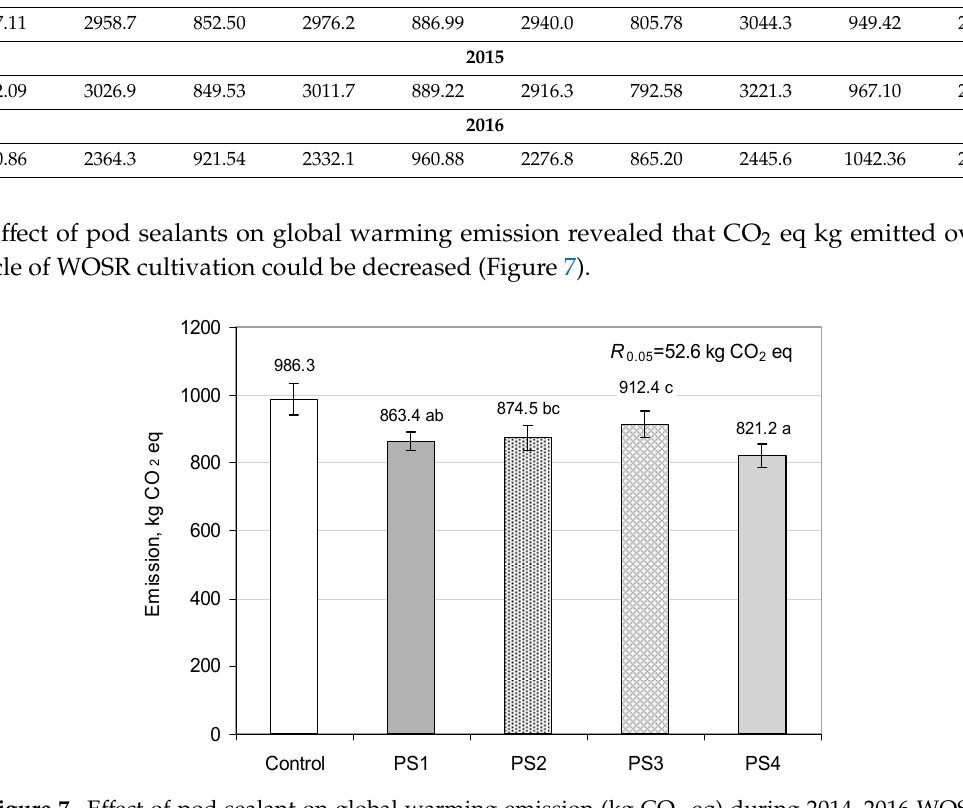
Figure 7. E ff ect of pod sealant on global warming emission (kg CO 2 eq) during 2014–2016 WOSR Figure 7. Effect of pod sealant on global warming emission (kg CO 2 eq) during 2014 – 2016 WOSR cultivation. Values with similar letters were not significantly di ff erent at p < 0.05 significance cultivation. Values with similar letters were not significantly different at p < 0.05 significance level.